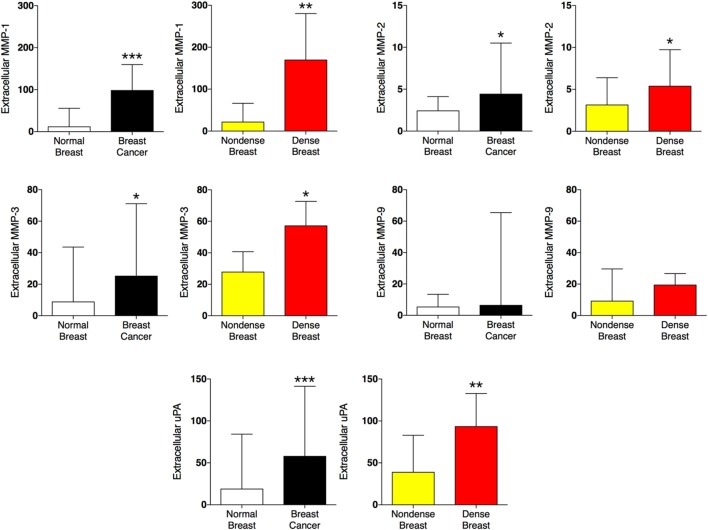
Extracellular levels of proteases in vivo in breast cancers and healthy normal breast tissue with different densities. 51 women were investigated using microdialysis; 12 breast cancer patients underwent microdialysis before surgery. One catheter was inserted into the breast cancer (black bars) and another into adjacent normal breast tissue (white bars). 39 postmenopausal healthy volunteer women, attending the regular mammography-screening program and were categorized as either having dense or non-dense breasts underwent microdialysis of their left breast. Women with dense breasts (n = 20) are depicted in red and women categorized as non-dense (n = 19) are depicted in yellow. Data represent protein abundance in linear values (2NPX as described in the Section “Materials and Methods”). Graphed data are presented as median with 95% CI (*P < 0.05, **P < 0.01, ***P < 0.001).